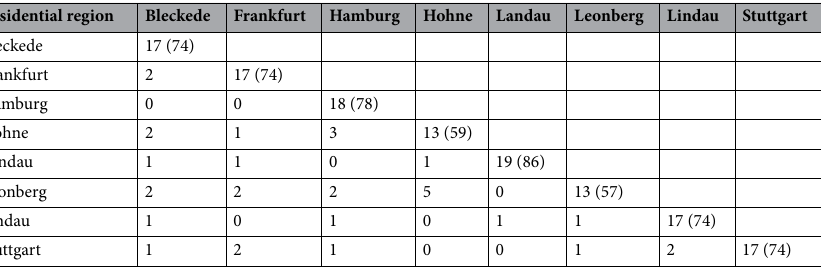
Table 10. Overview on the number of stray subpopulation-specific selective events. The number of subpopulation-specific selective events was estimated by comparing one subpopulation for each of the eight subpopulations with the other seven subpopulation. For each stray subpopulation, the number (and percentage) of subpopulation- specific selective events are given.